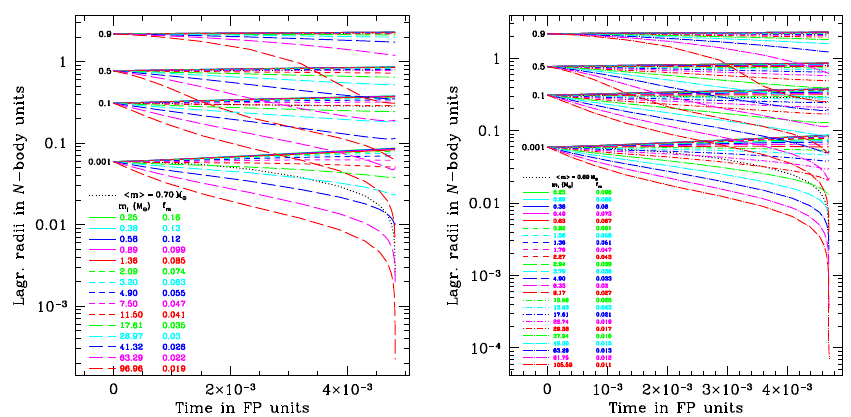
Fig. 31 Lagrangian radii for each stellar mass m i for the cases of 25 and 15 mass components